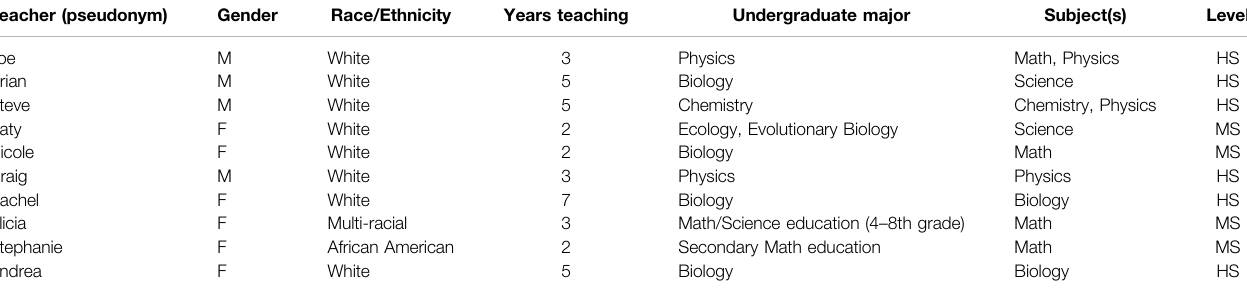
TABLE 2 | Interview participant